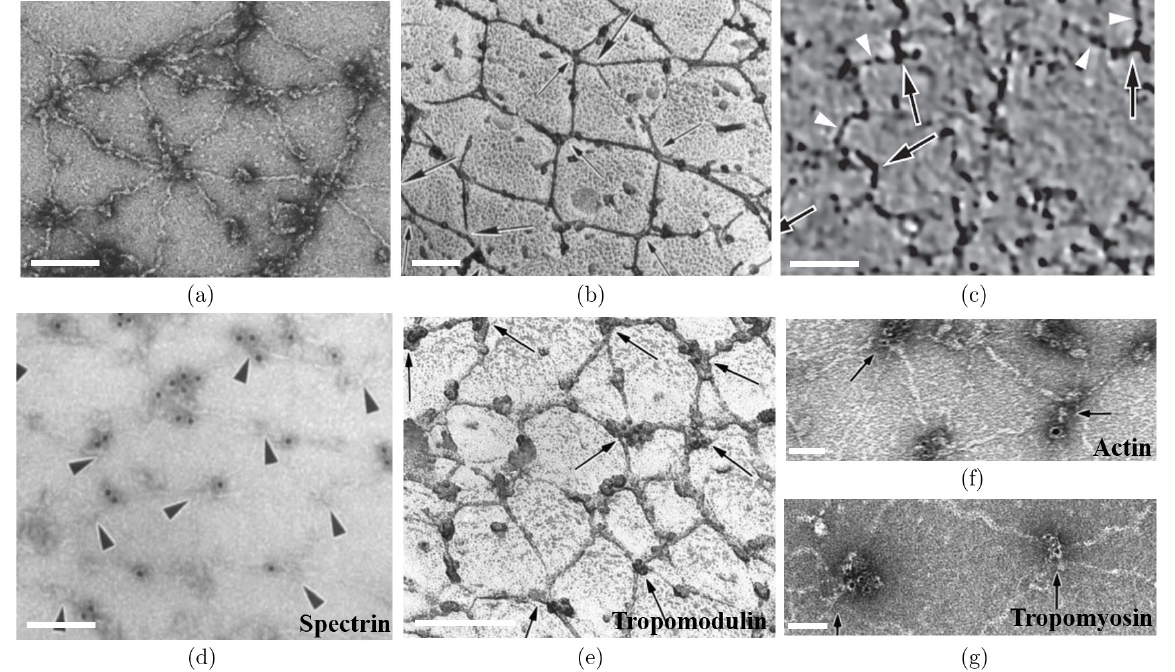
Fig. 5. The ultrastructure of the erythrocyte membrane-skeleton shown by di®erent kinds of EM. (a) Spread erythrocyte mem- brane-skeleton imaged by negative-staining EM. (b) An un¯xed erythrocyte membrane-skeleton visualized by QFDERR. (c) Cryo- electron tomography of the intact, unexpanded membrane-skeleton showing a complex ¯lament meshwork. (d) Immunogold la- beling of spectrin in human erythrocyte membrane-skeleton visualized by negative staining. (e) Immunogold labeling of TMOD in erythrocyte membrane-skeleton obtained by QFDERR. (f, g) Immunogold labeling of actin (f) and tropomyosin (g) in erythrocyte membrane-skeleton visualized by negative staining. Scale bar ¼ 100 nm. (a) is adapted from Ref. 70, (b) and (d) are adapted from Ref. 16, (c) is adapted from Ref. 14 and (e) (f) and (g) are adapted from Ref.